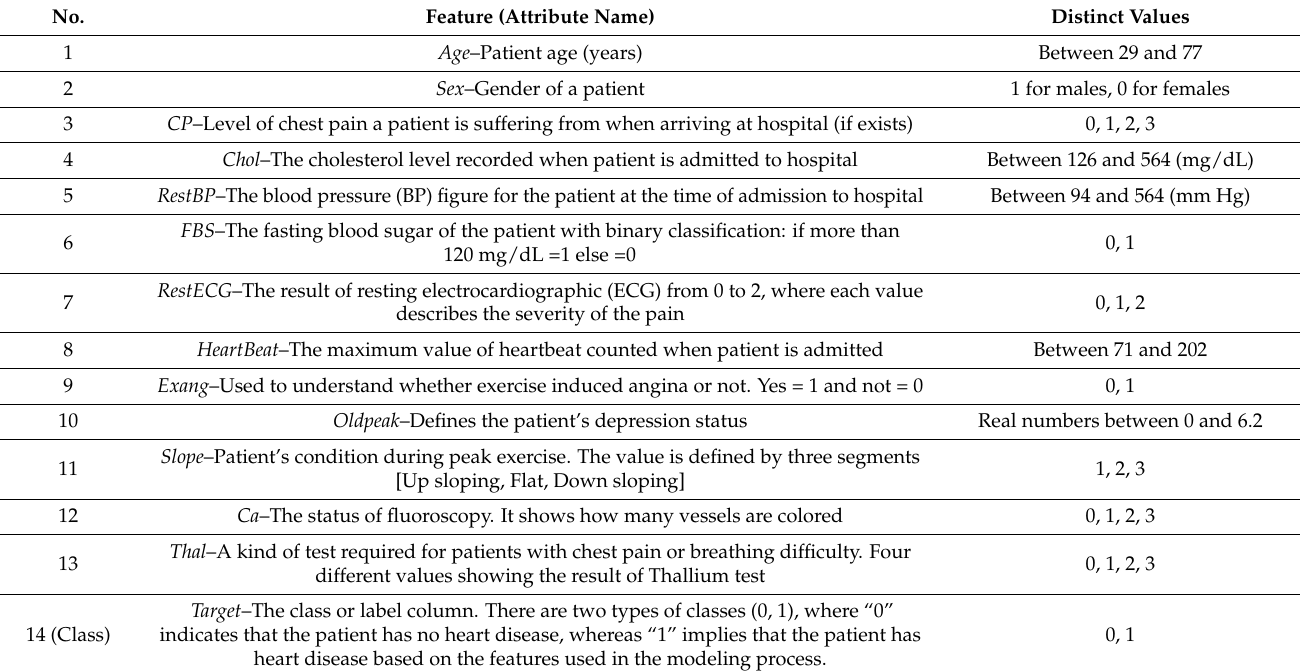
Table 1. The resultant features from the UCI